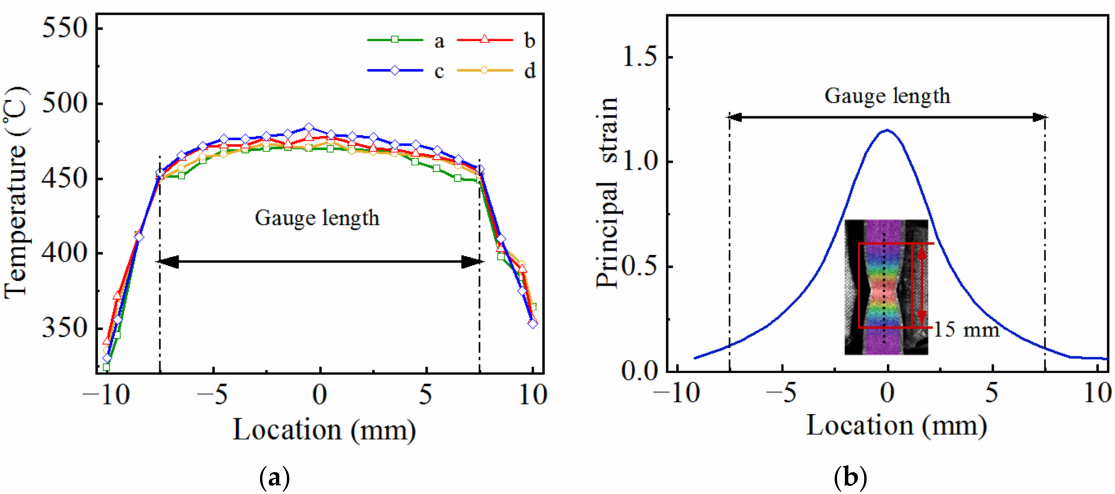
Figure 3. Temperature field and strain field of the specimen s urface at the moment of fracture: ( a ) temperature field; ( b ) strain field.